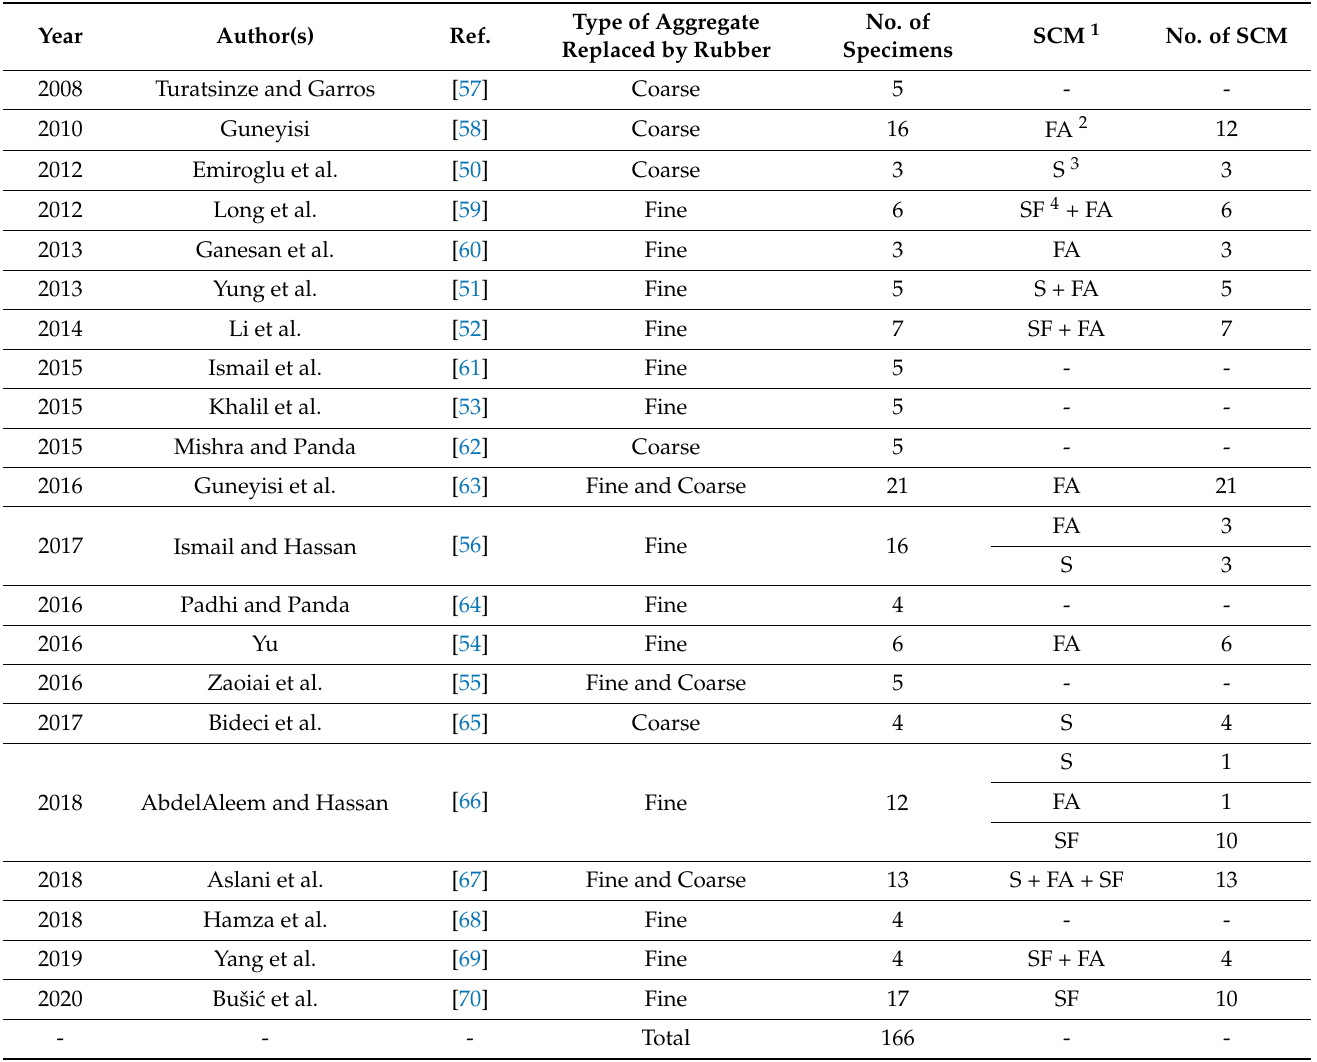
Table 3. Statistical analysis of the properties of the database of SCRC